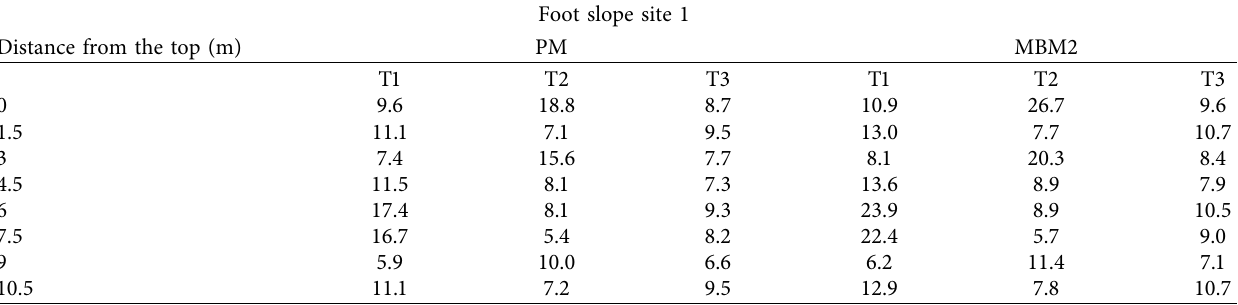
Table 1: Soil erosion rates in t/ha/yr associated with site 1 for different points of the transects using the Proportional Model (PM) and Mass Balance Model 2 (MBM2).